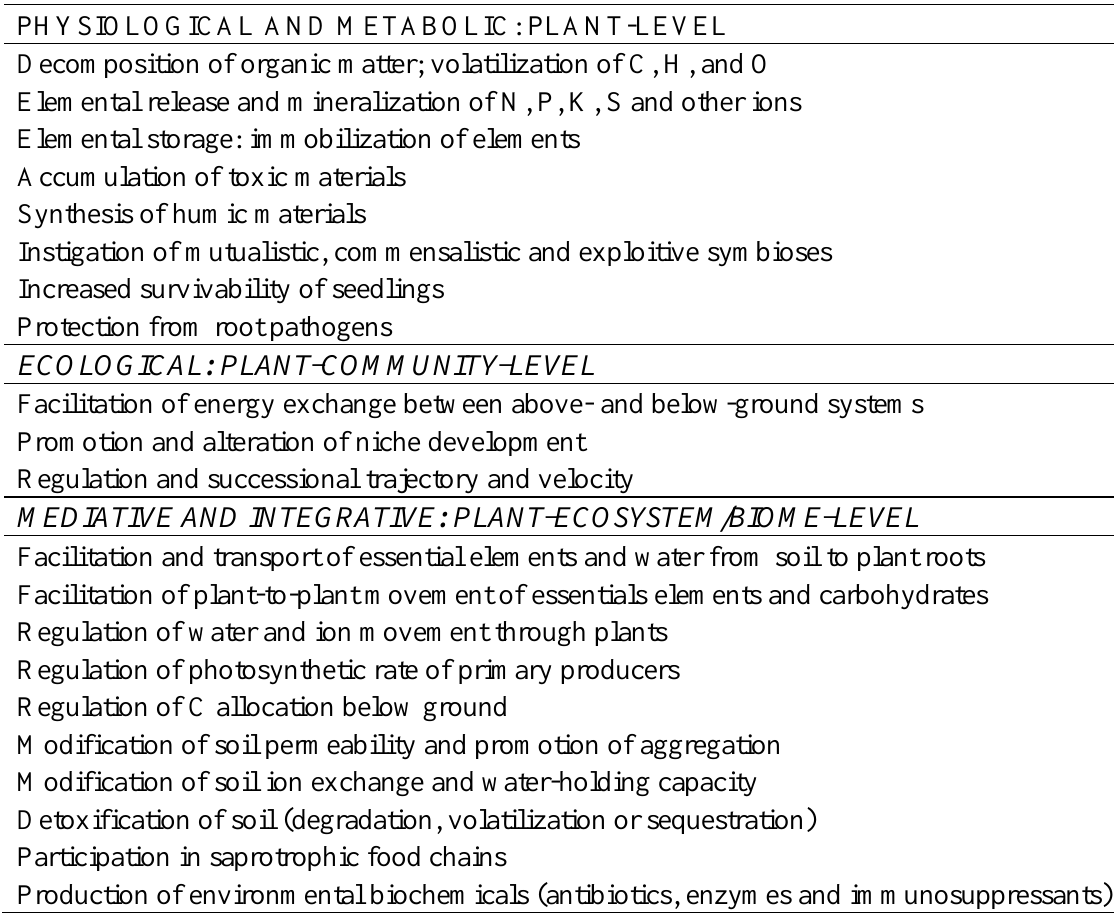
Table 1. Functions of mycorrhizal fungi in ecosystem processes (adapted from Miller